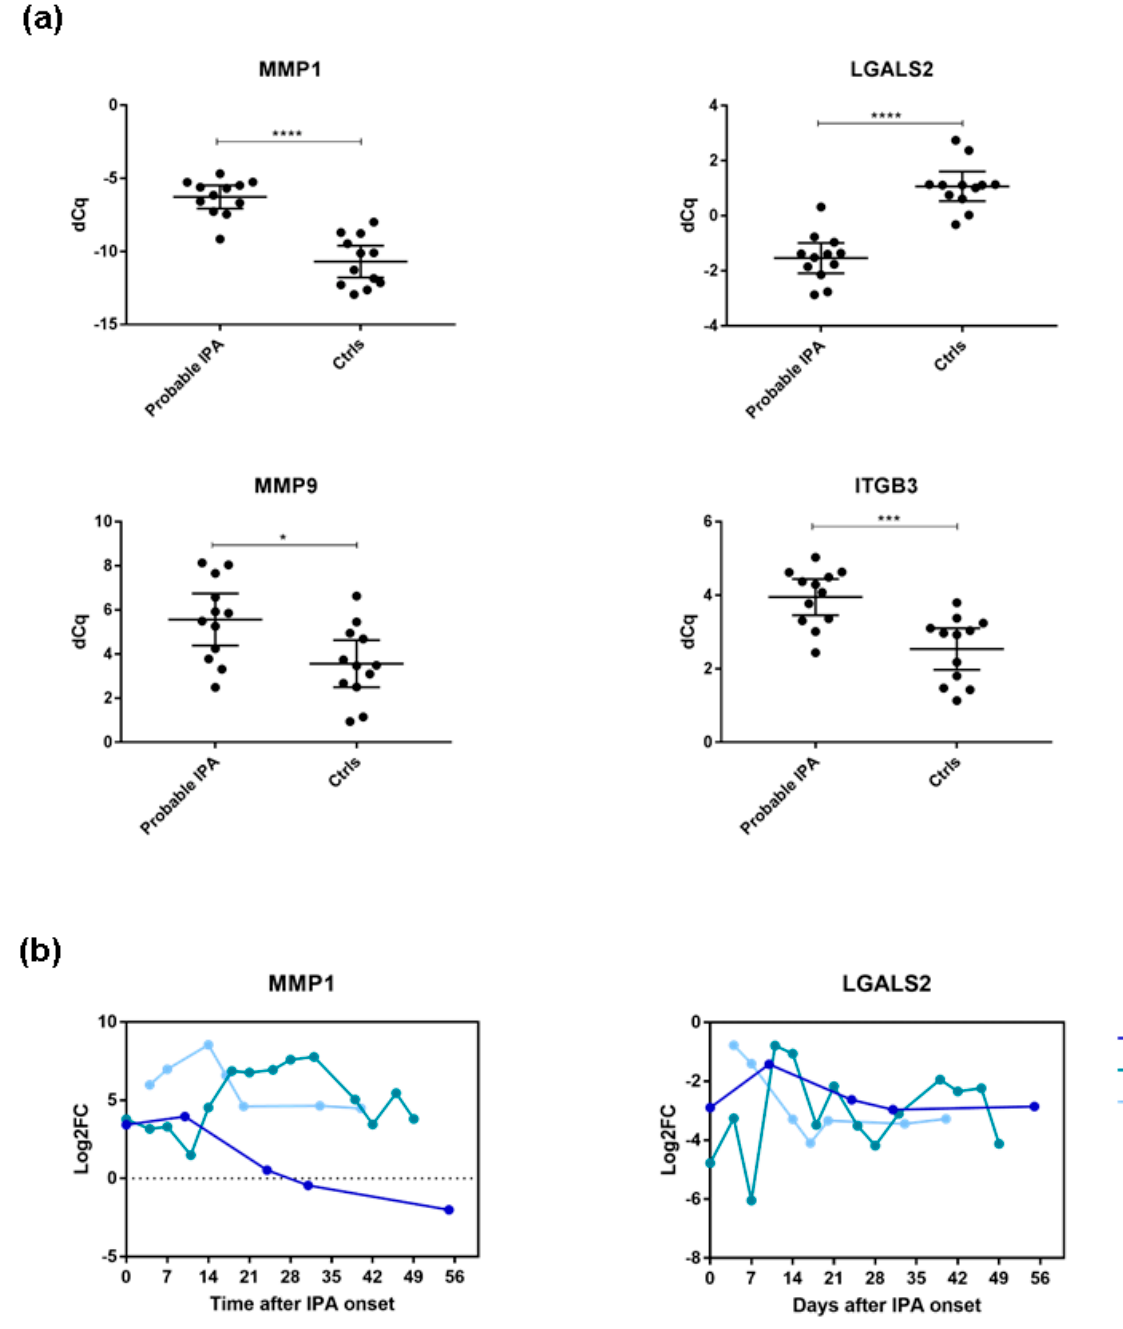
Figure 3. Gene expression of selected molecular candidates in probable IPA cases and their matched controls evaluated by real-time PCR. ( a ) Mean expression of MMP1 , LGALS2 , MMP9 , and ITGB3 in selected three probable IPA cases and their matched controls within 35 days after IPA onset ( n = 24). Data are shown as mean ∆ Cq values with 95% confidence intervals. ( b ) MMP1 and LGALS2 expression levels in probable IPA cases according to their matched controls within 56 days after IPA onset indicated as log 2 of fold changes (log2FC). n , number of patient samples. Significant differences among investigated cases and controls were determined by the Mann–Whitney test (* p < 0.05, *** p < 0.001, **** p < 0.0001).